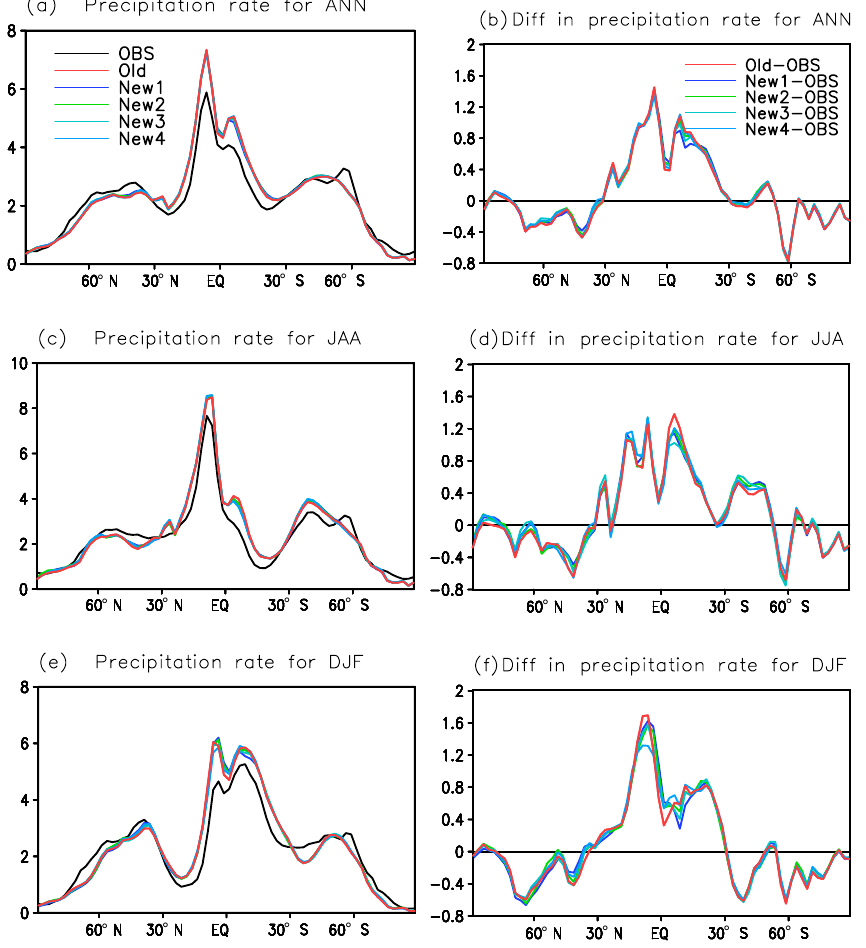
Figure 4. Annual, JJA, and DJF zonal mean of the total precipitation rate (mmday − 1 ) derived from CAM5.1 ( a , c , and e ) and the GPCP observations (OBS), and their corresponding difference between OBS and Old, as well as News ( b , d , and f